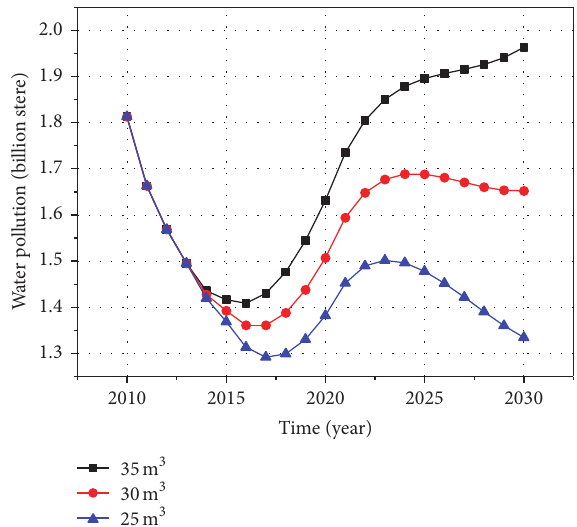
Figure 9: Water pollution under different per ten thousand yuan GDP water consumption.